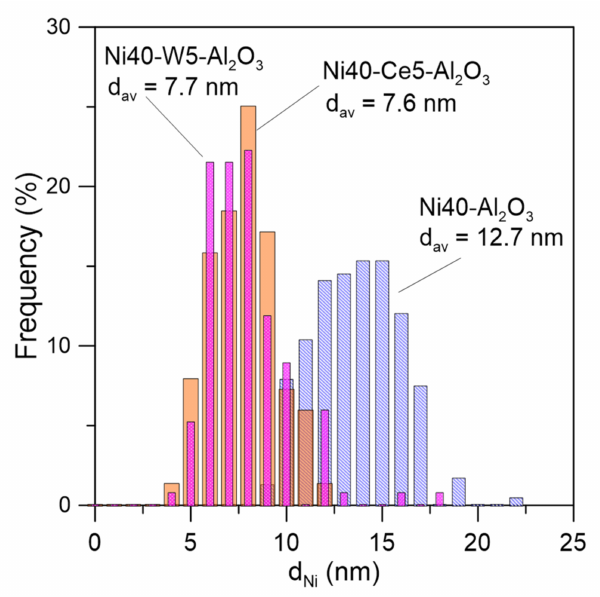
Figure 6. Nickel crystallite size distribution in selected catalysts after reduction determined from TEM